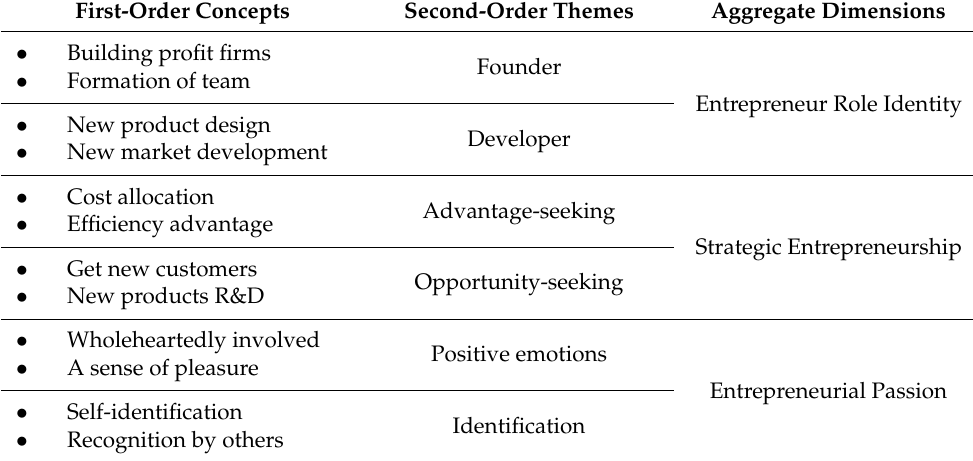
Table 3. Example of Data